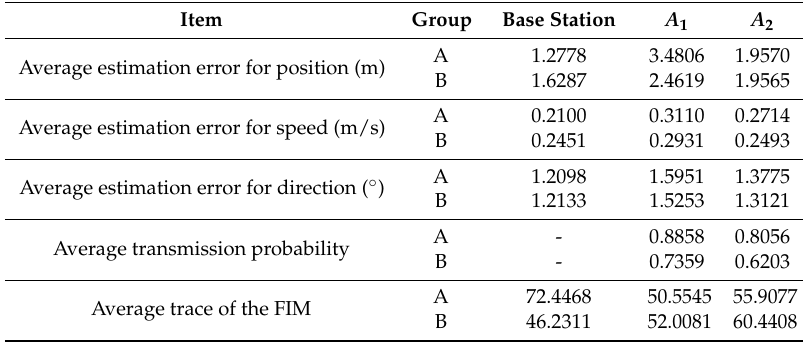
Table 3. Comparison of the average estimate errors, the average transmission probabilities, and the average trace of the FIM in Scenario 1 (Group A vs. Group